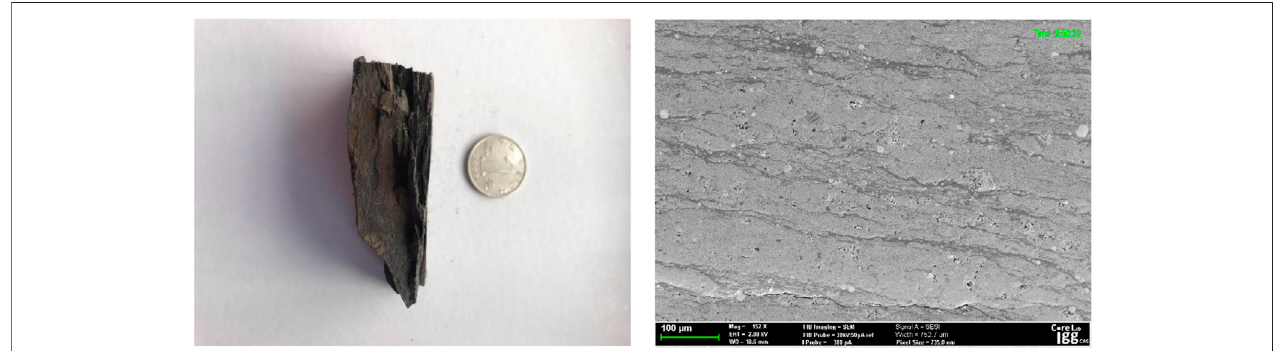
FIGURE 2 | A photographic image and scanning electron microscopy image of the Xiamaling shale specimen.